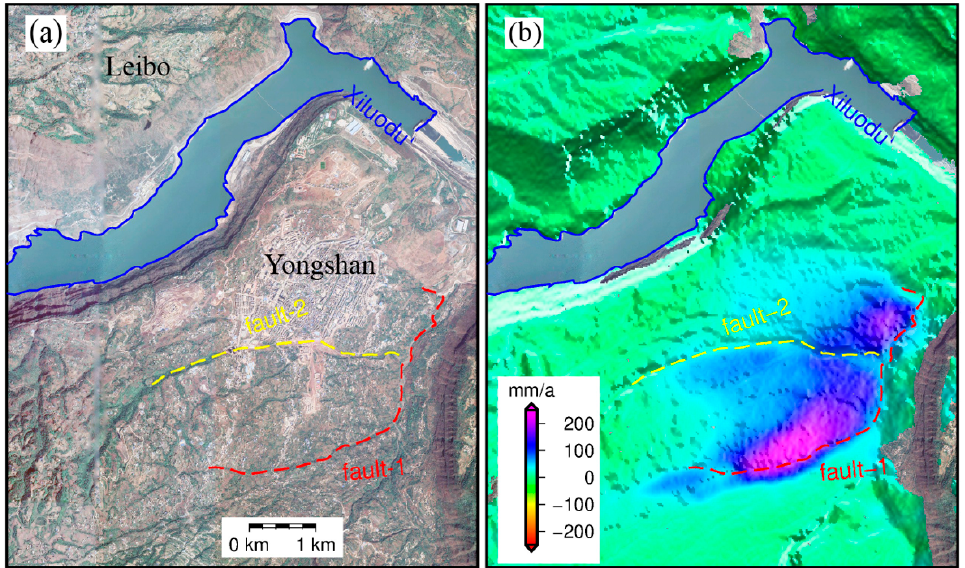
Figure 17. ( a ) Optical image; ( b ) potential